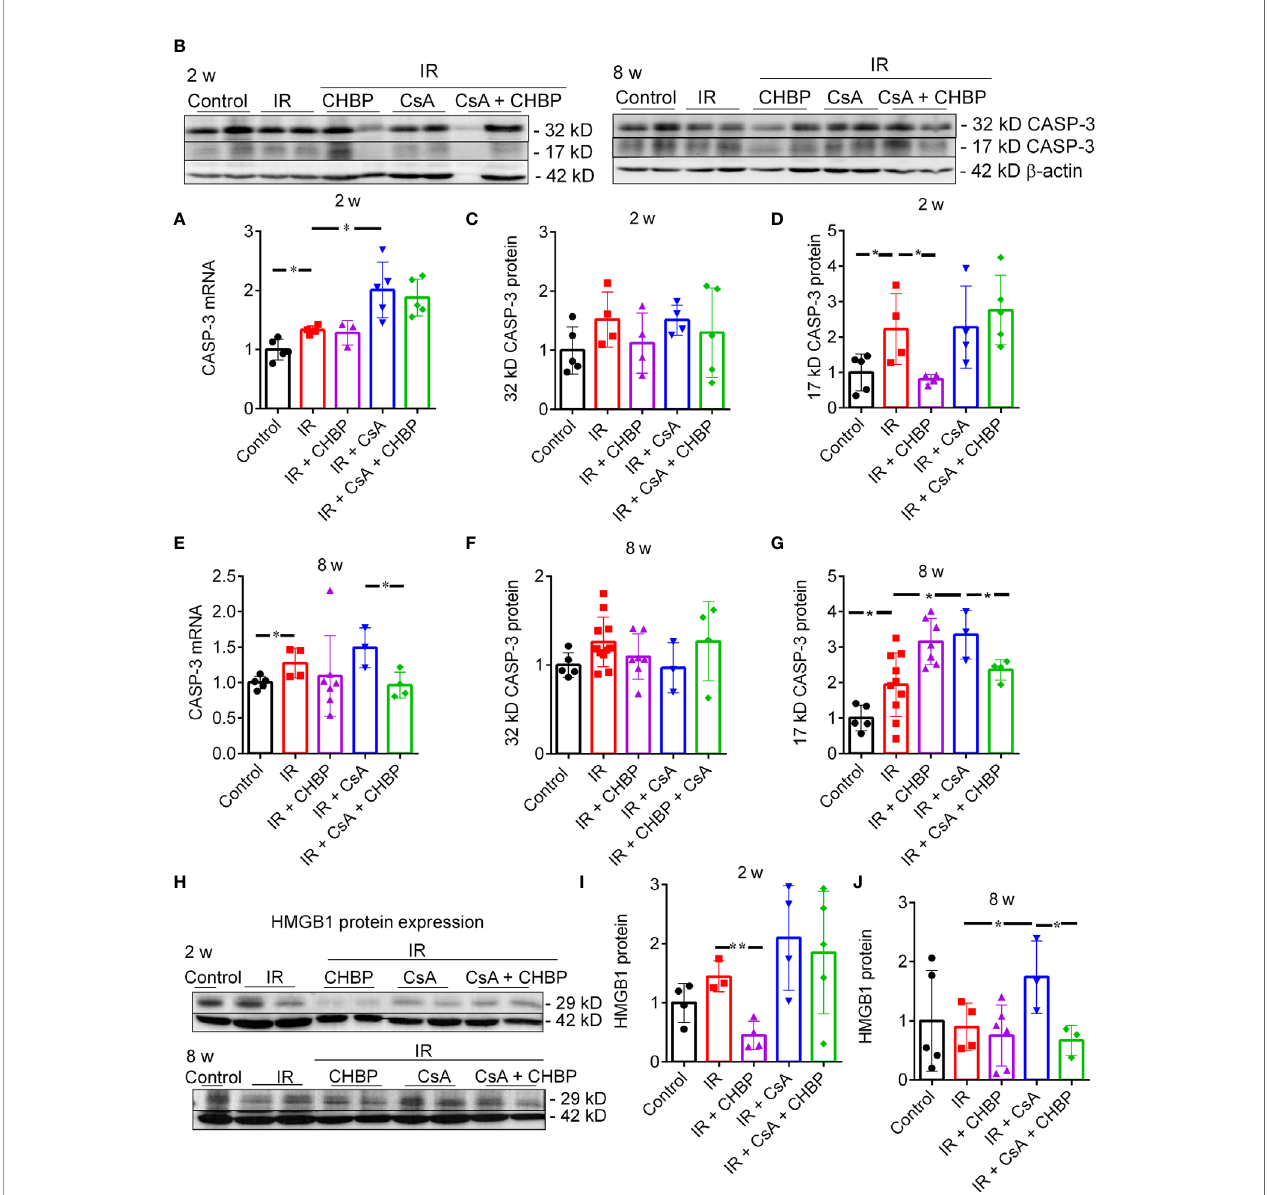
FIGURE 5 | CASP-3 mRNA and protein, and HMGB1 protein expression. (A, E) The relative expression of caspase 3 mRNA was increased by IR at both time points, and further increased by CsA at 2 weeks, but decreased by CHBP in the CsA group at 8 weeks. (B – D, F, G) The level of 17 kD active CASP-3 protein was increased by IR and reversed by CHBP at 2 weeks, and increased by CsA at 8 weeks and also reversed by CHBP. (H – J) The expression of HMGB1 protein in 2 and 8 weeks was detected by western blotting. The level of HMGB1 was signi fi cantly decreased by CHBP in the IR group at 2 weeks, increased by CsA compared with the IR group and reversed by CHBP at 8 weeks. Data were expressed as the mean ± SD (n ≥ 3). The volume density of western blots was corrected by against 42 kD b -actin as a loading control. * P ≤ 0.05; ** P ≤